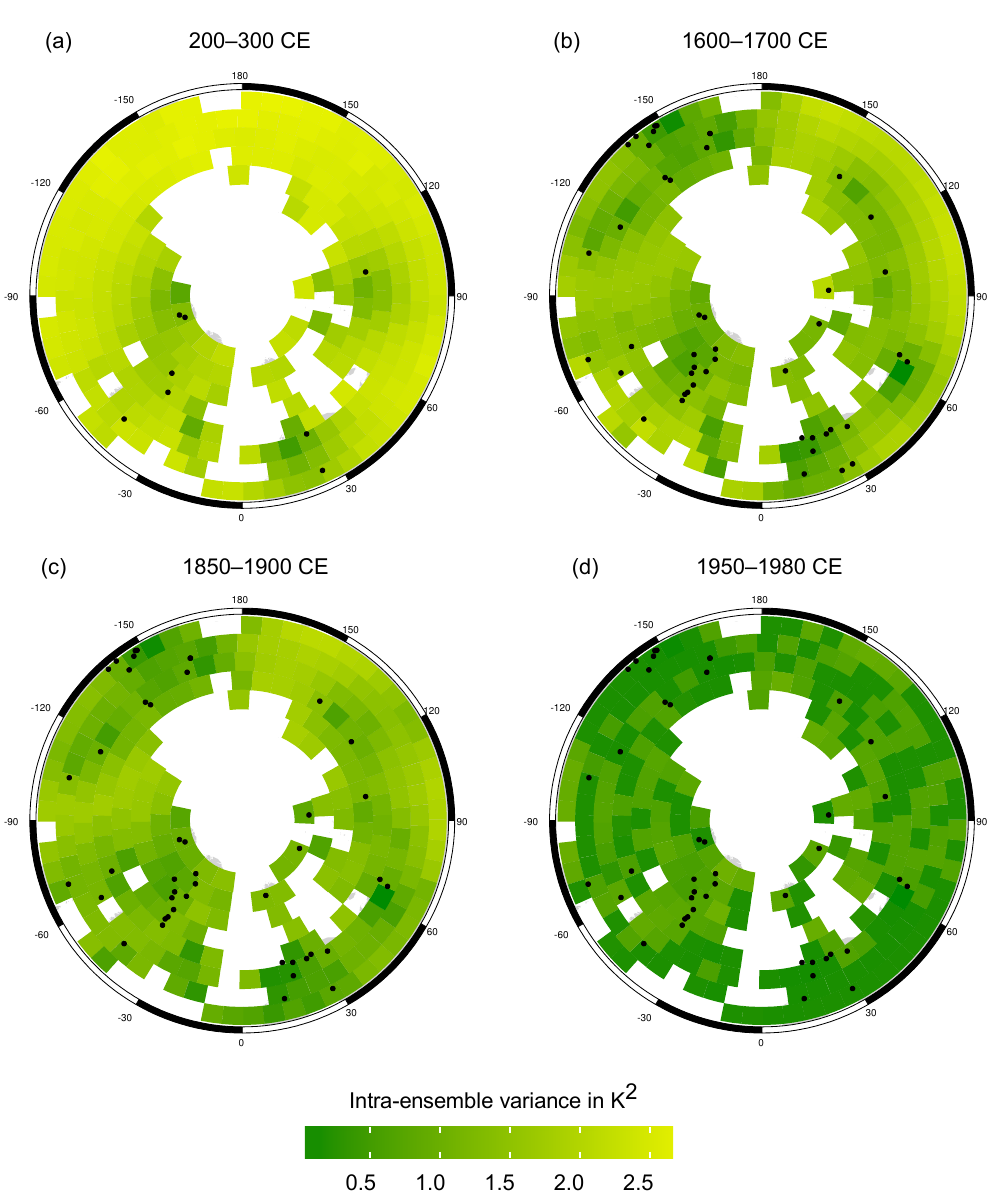
Figure B2. Time-averaged intra-ensemble variance of the Arctic2k reconstruction shown for the four sub-periods with a distinct difference in proxy data density (200–300CE vs. 1600–1700CE, panels a and b ) and calibration sub-periods with different instrumental data coverage (1850–1900 vs. 1950–1980CE, panels c and d ). Black dots show the proxy locations with at least one data point over the period of